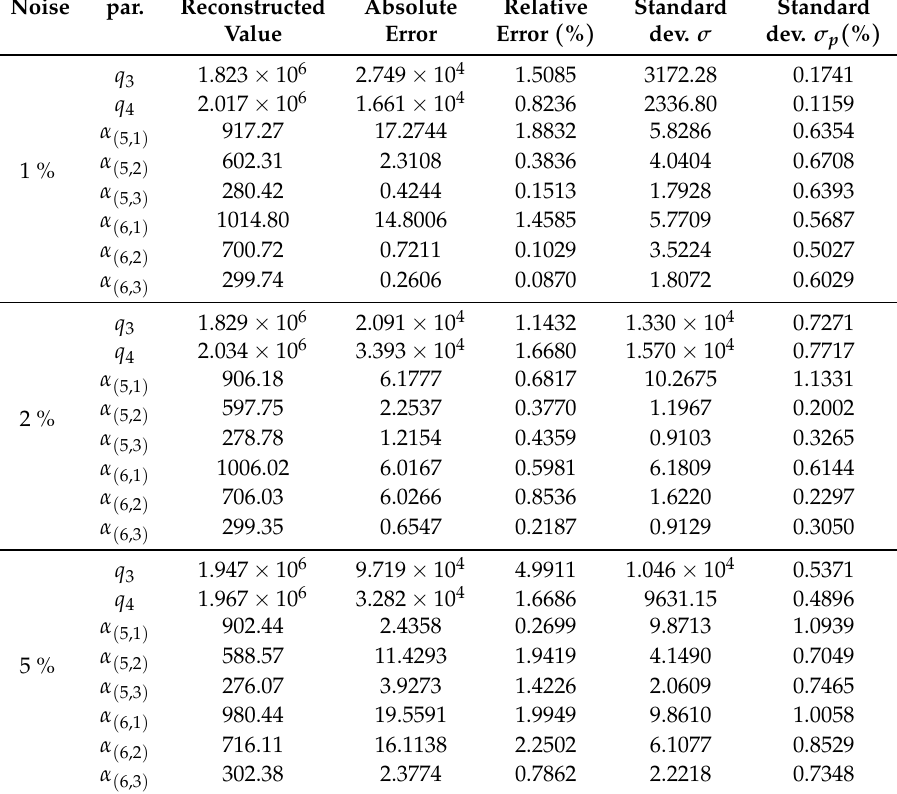
Table 5. Reconstructed values of the unknown coefficients together with the absolute and relative errors of these reconstructions, the standard deviation σ and the standard deviation σ p taken as the percentage of the best reconstructed value, obtained for the measurements read at every 0.01m (two steps optimization).